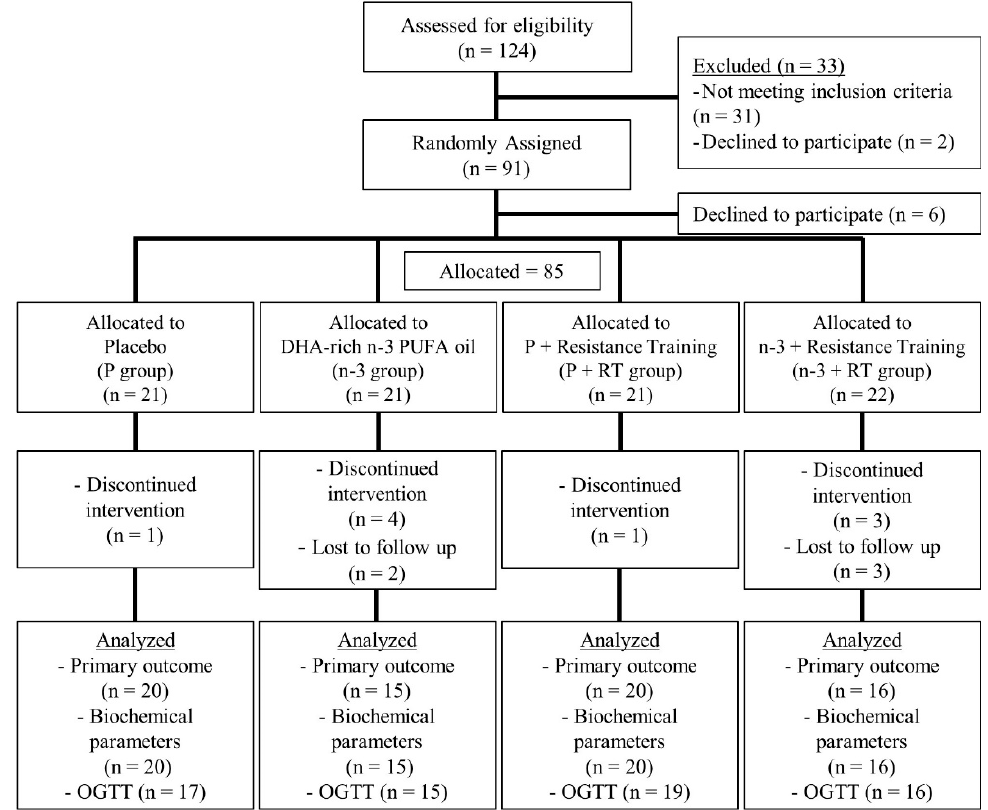
Figure 1. Flowchart of participants from the screening to the endpoint visit of the study (16 weeks). In total, 85 out of the 91 women who met the inclusion criteria started the intervention. Further, 14 participants did not complete the study (16.5% drop out), as they either discontinued follow-up due to unexpected health problems ( n = 5, 3 unrelated to the study and 2 related to capsules consumption), time incompatibilities ( n = 2), withdrew from the study ( n = 3), or were not compliant with the training sessions ( n = 4). There were two dropouts in the n-3 group probably related to capsules consumption, one of them was related to gastroesophageal reflux and the other one related to itch in the hands. Dropout rates were 4.8% for P and P+RT groups, 28.6% for n-3 group and 27.3% for n-3+RT group. For Oral Glucose Tolerance Test (OGTT) analyses, 3 subjects were excluded due to problems with venous insertion of the catheter in the P group, and 1 subject was excluded due to lack of measure at one timepoint of the glucose excursion curve in the P+RT group. DHA: Docosahexaenoic Acid; PUFA: Polyunsaturated Fatty Acids.